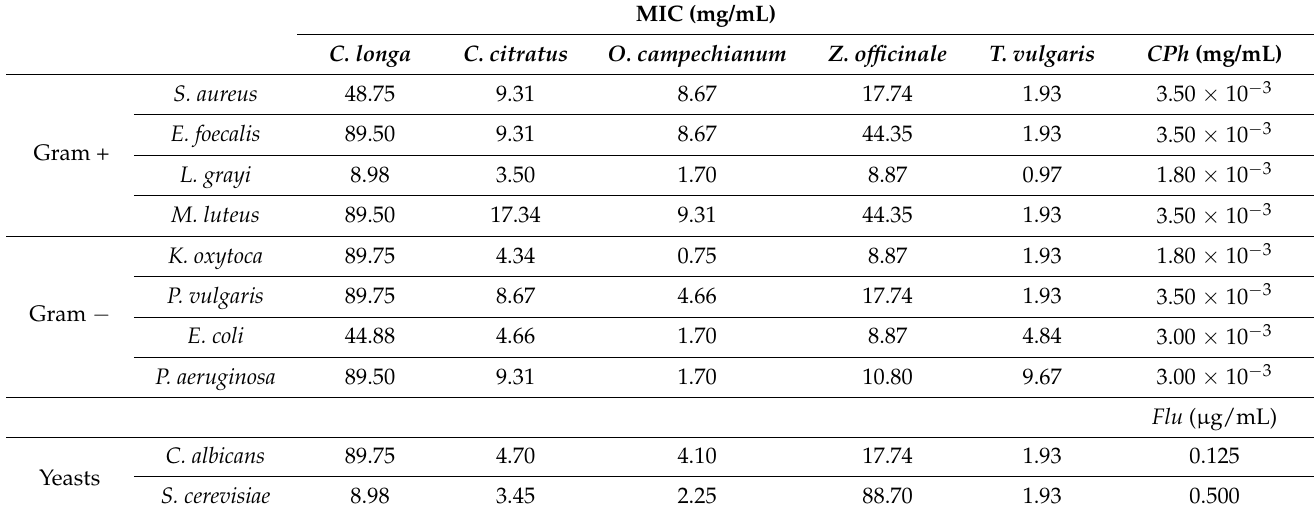
Table 5. Antimicrobial activities of EOs from the studied species compared with that of commercial T. vulgaris . Chloramphenicol ( CPh ) and fluconazole ( Flu ) were used to test the sensitivity of bacterial and yeast strains